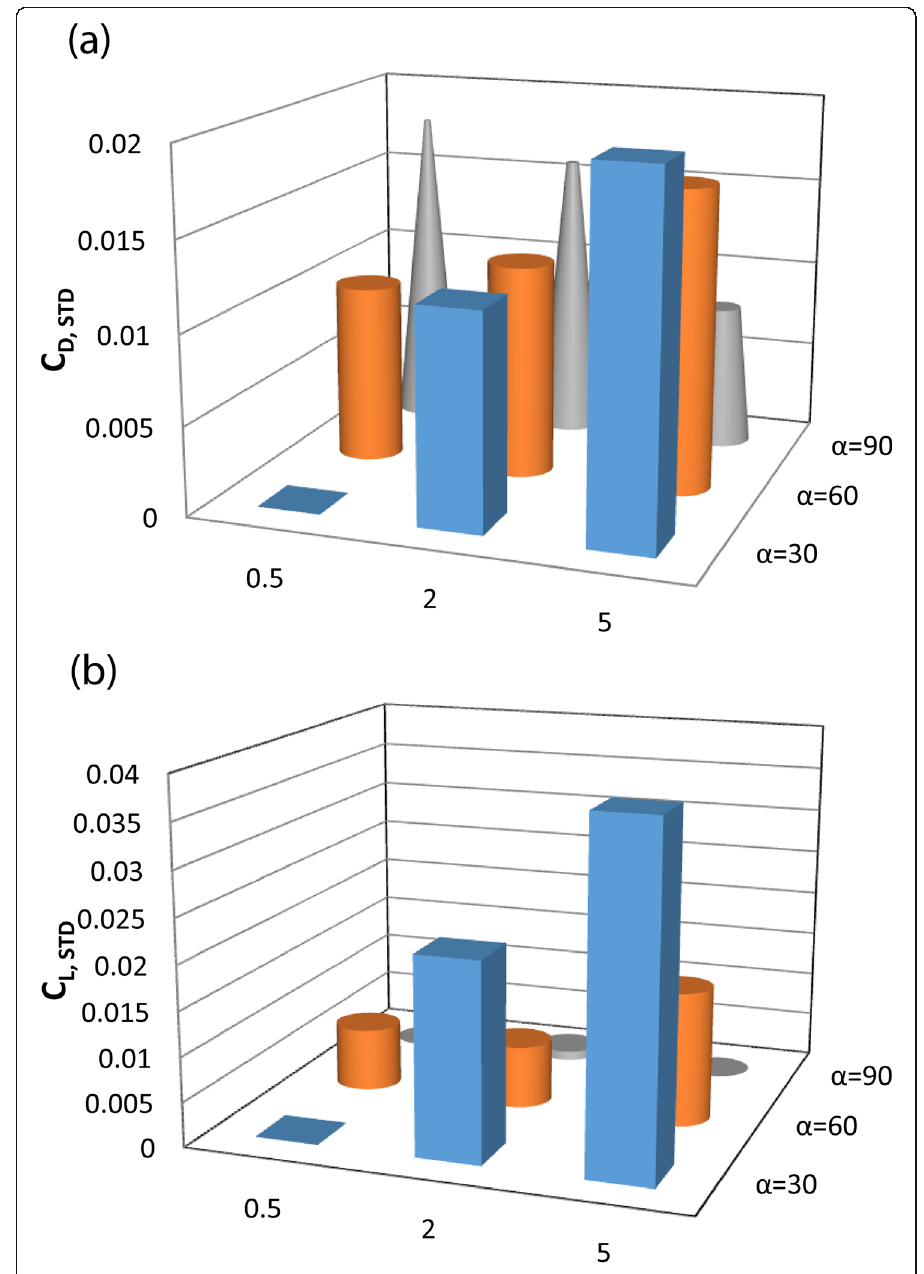
Fig. 9 Standard deviation of a ) drag force and b ) lift force at α = 30°, 60°, 90° and AR = 0.5, 2,